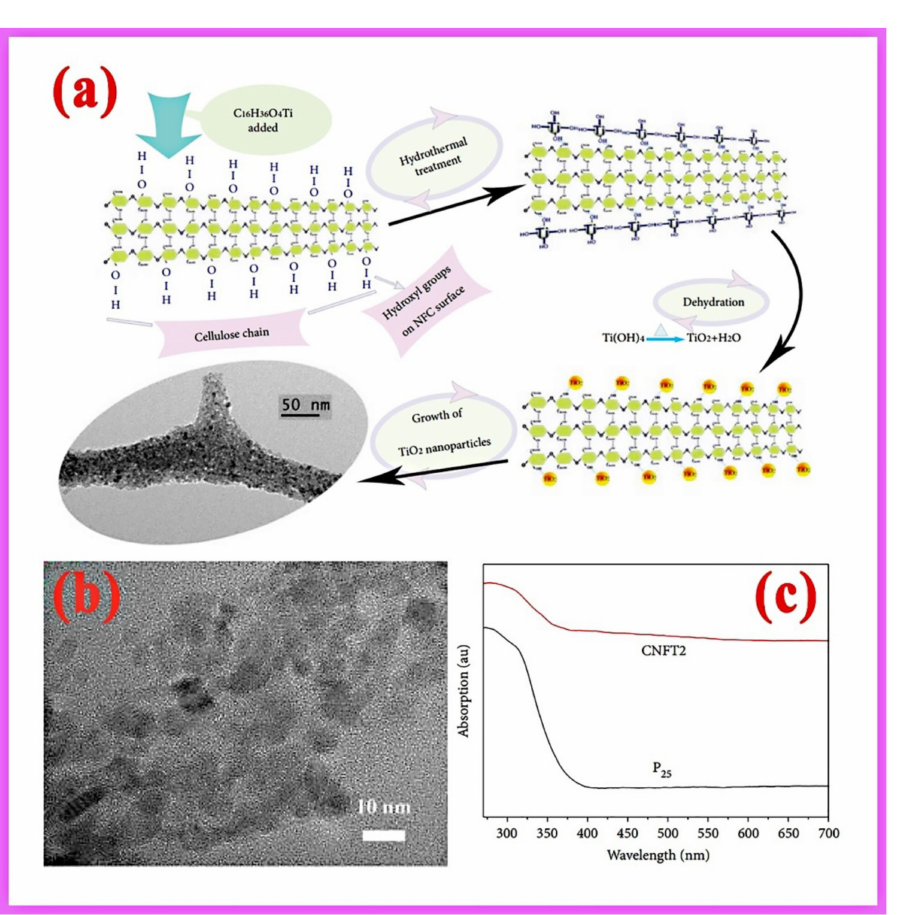
Figure 2. ( a ) Synthesis mechanism of cellulose nanotitanium dioxide aerogel (CNFT); ( b ) TEM micrograph of CNFT2; ( c ) UV-Vis spectra of P25 and CNFT2